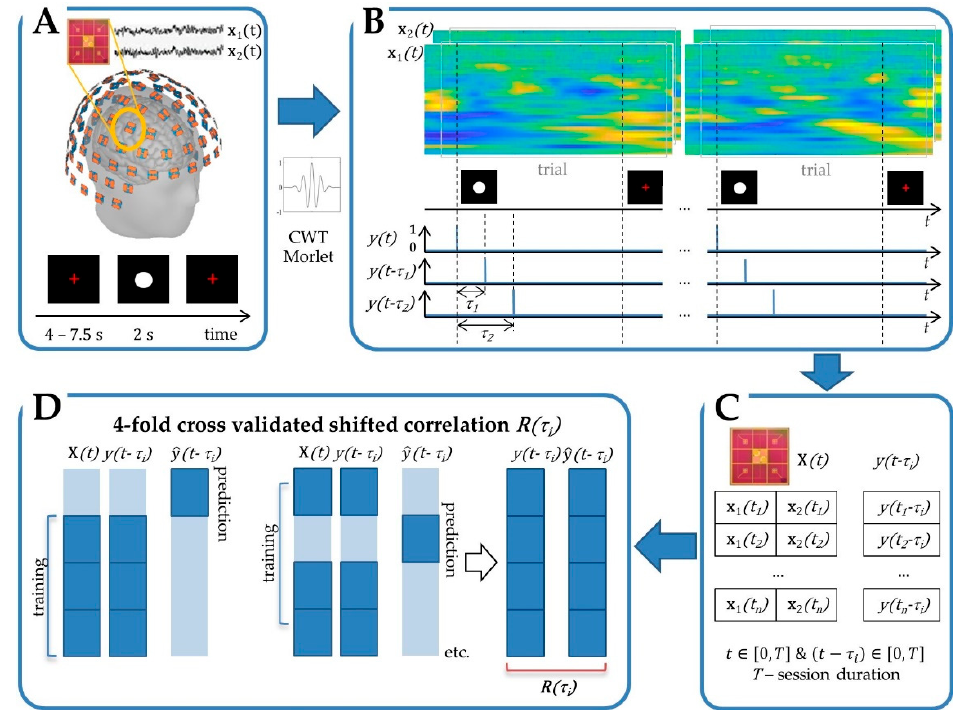
Figure 1. Cross-validated shifted multiple correlation is calculated in sensor space. ( A ) Neural signal recording with Elekta Neuromag system comprising 306 measurement channels organized in channel-triplets (two planar gradiometers and one radial magnetometer, not used in this study), on 102 silicon chips, in a helmet-shaped array. ( B ) Spectral decomposition using Morlet continuous wavelet transform (CWT) and feature extraction. ( C ) Matrices of features (e.g., for a channel-doublet of two gradiometers) and shift ( τ i ) for a given session, including trials and basic activity periods. ( D ) Four-fold cross-validated shifted multiple